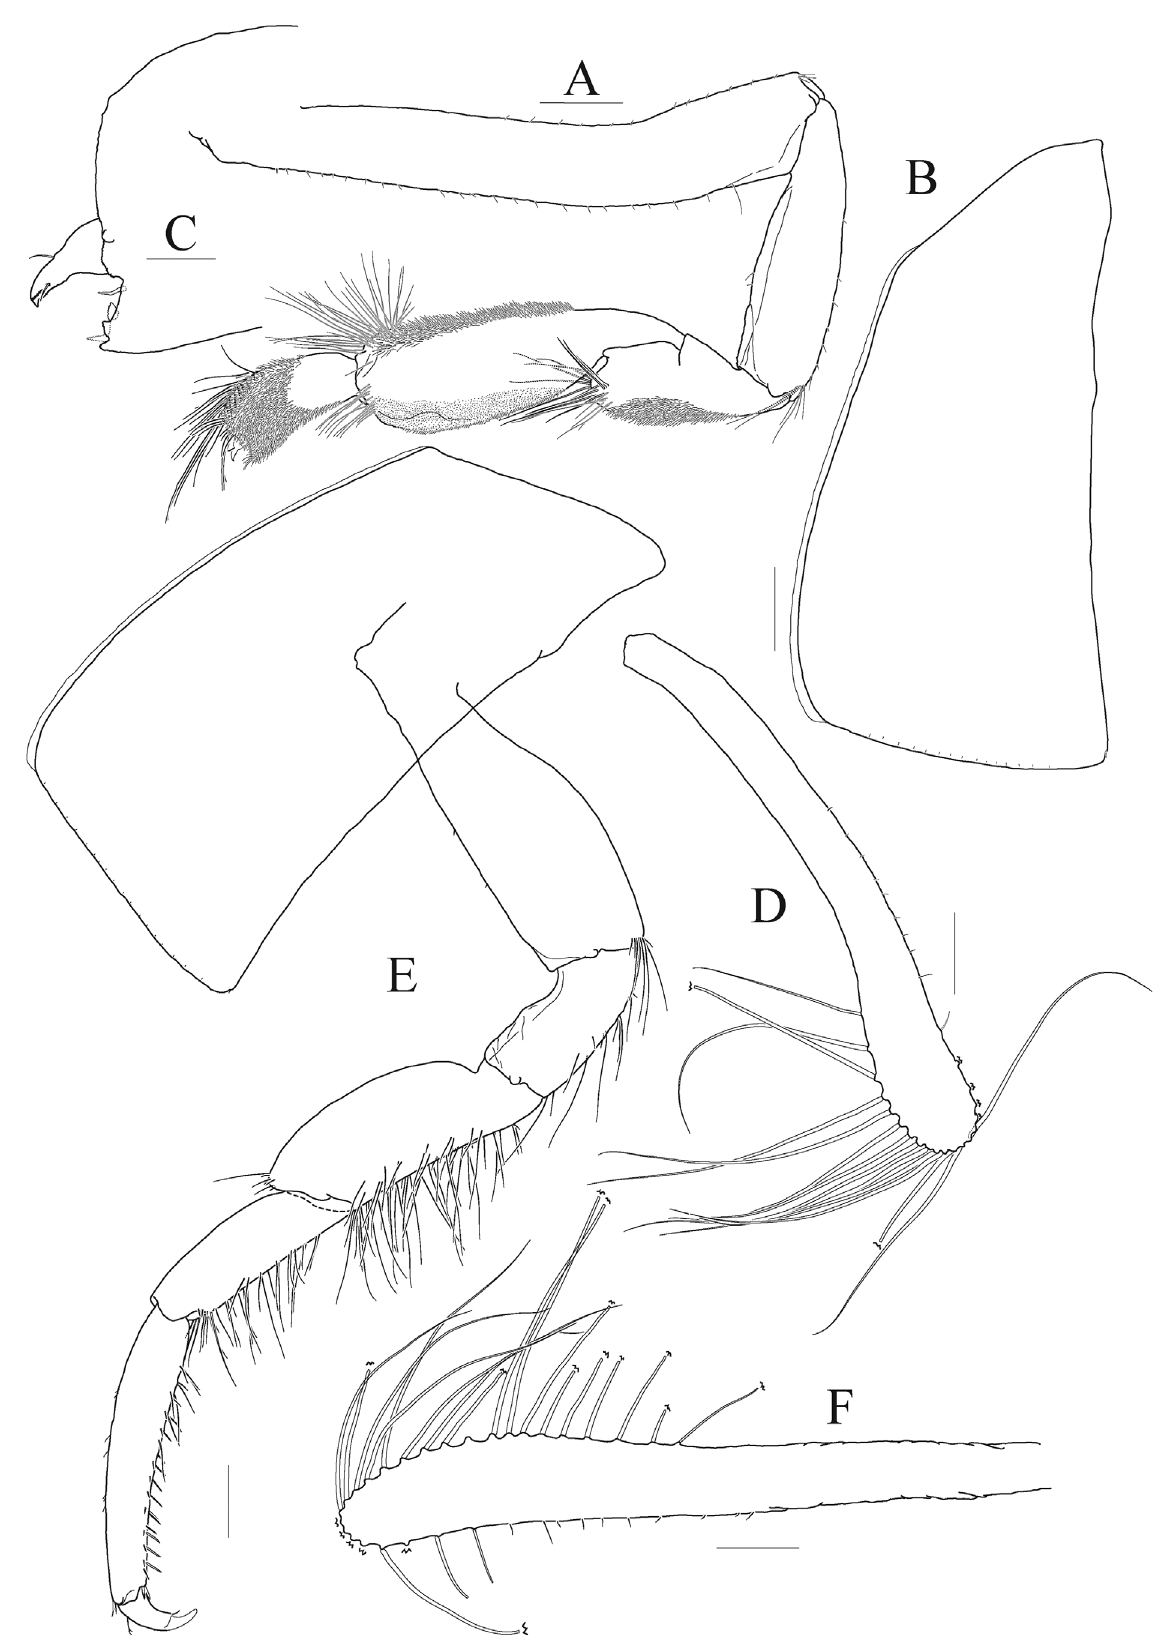
Figure 3. Pseudorchomene boreoplebs sp. n., holotype female (27.1 mm), NIBRIV0000806535. A gnathopod 2; B coxa 2; C palm and dactylus of gnathopod 2; D oostegite of gnathopod 2; E pereopod 3; F oostegite of pereopod 3. Scale bars 0.1 mm ( C ), 0.5 mm ( A, B, D–F